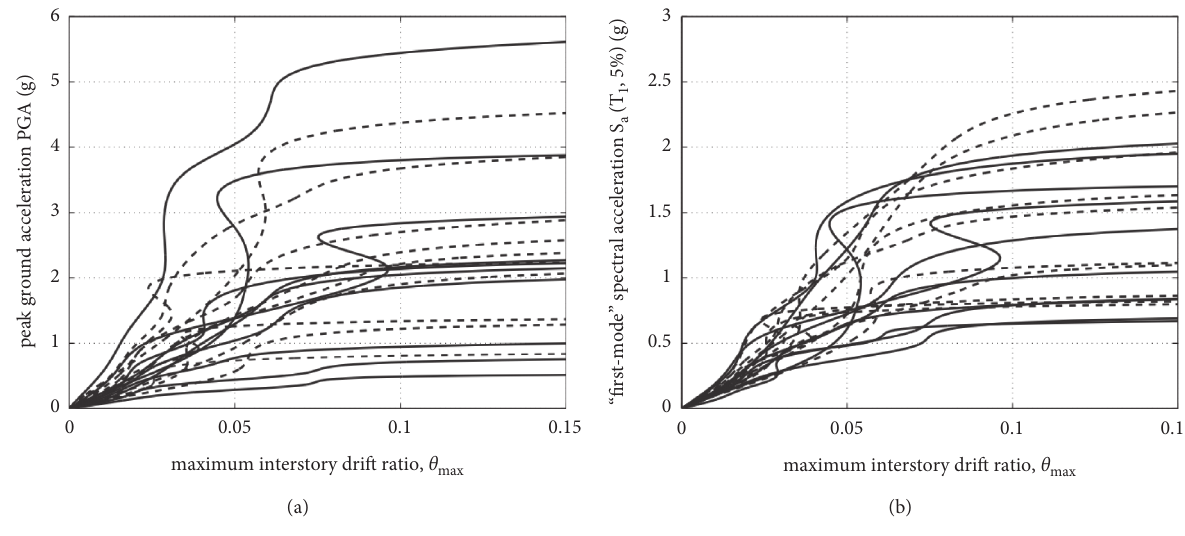
Figure 5: IDA curves for, T1 � 2.2sec, a 9-story steel moment-resisting frame with fracturing connections plotted against (a) PGA and (b) Sa (T1, 5%) [15].